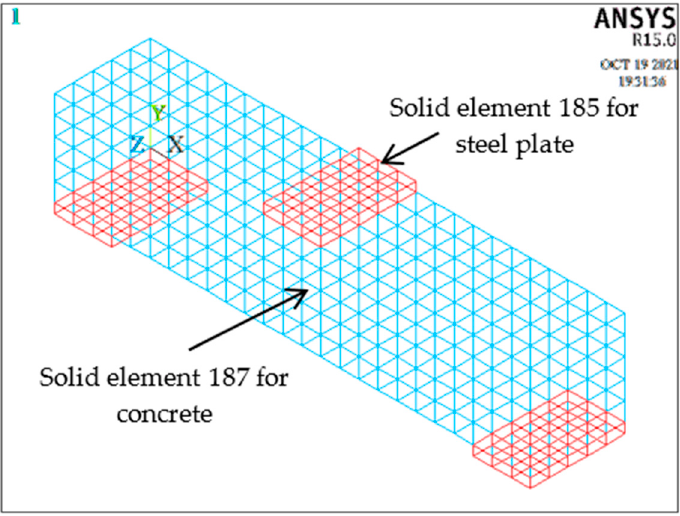
Figure 6. 3D view of the concrete and steel plate elements (wireframes) of a typical beam model.